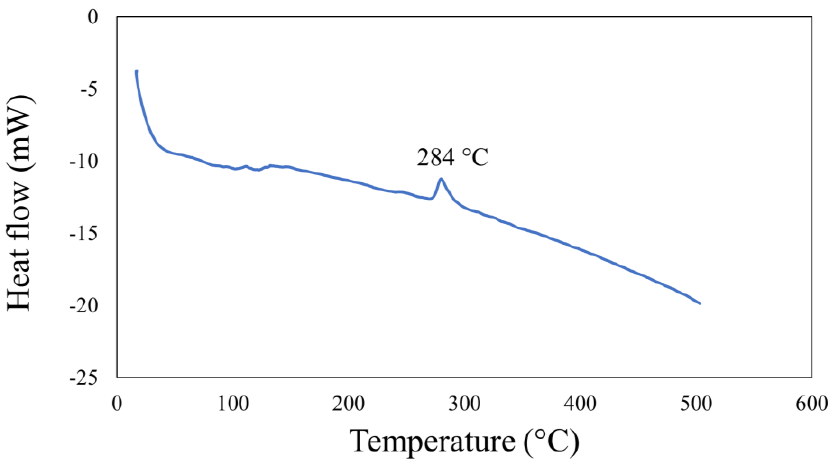
Figure 1. DSC trace of the ENB deposit.